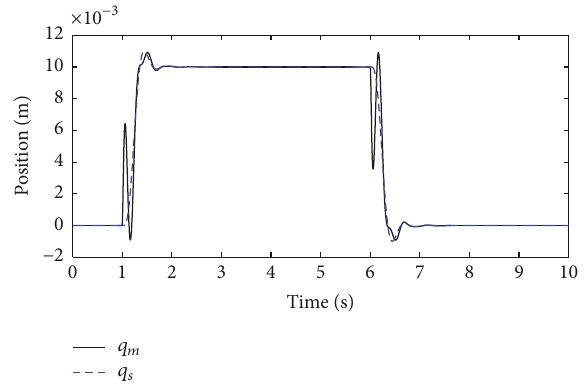
Figure 7: Position tracking performance when there are no delays in the communication channel.